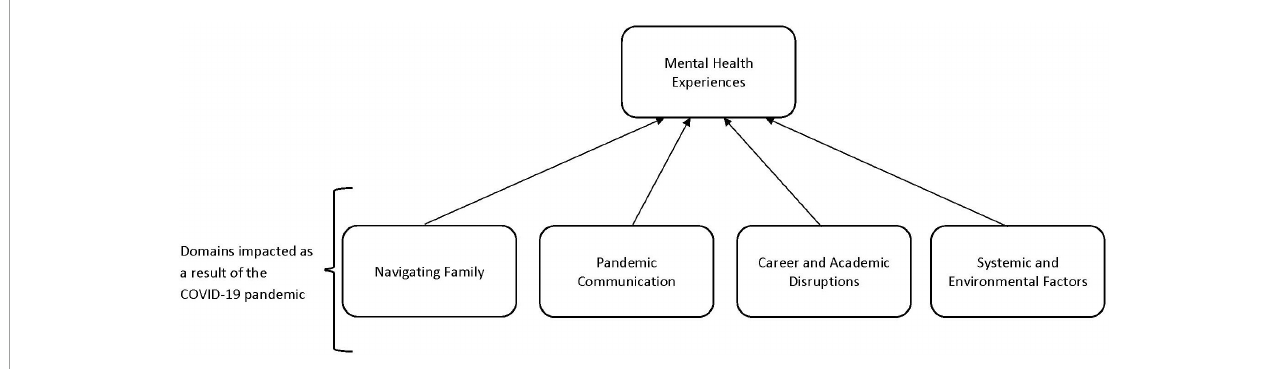
FIGURE1 Model of psychosocial functioning of Latinx emerging adults as a result of the